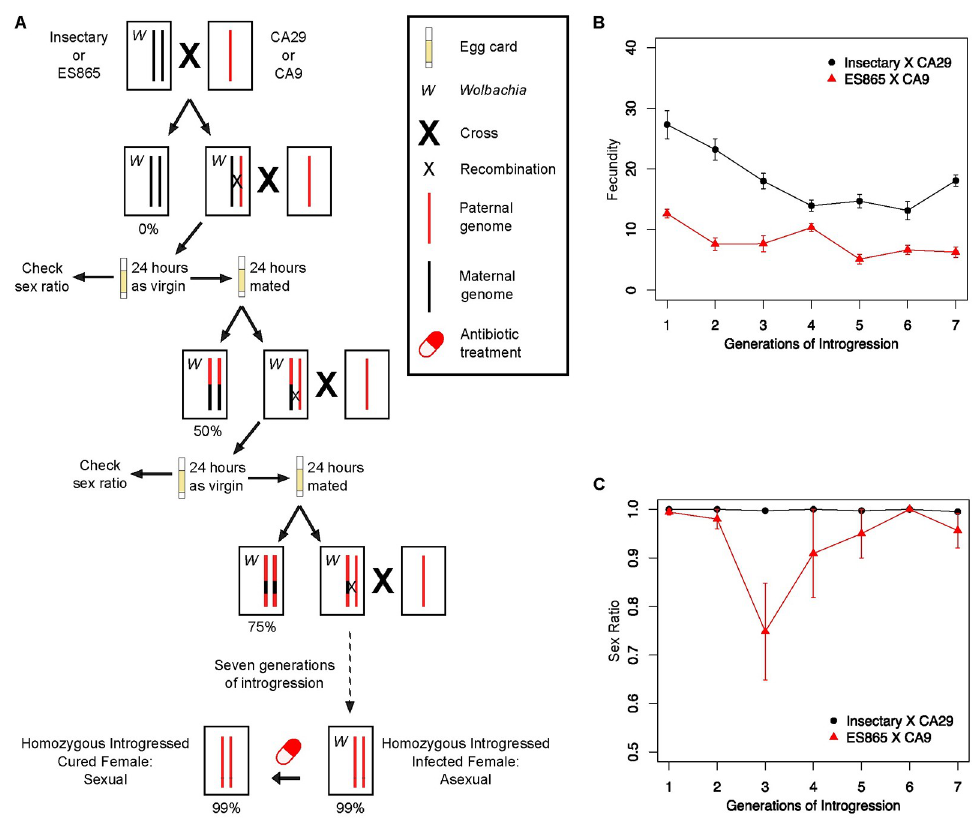
Fig 1. Crossing scheme for creating homozygous introgressed isofemale lines and fitness at each introgression generation. A) After seven generations of introgression, between 95–99% of the Wolbachia -dependent asexual nuclear background was replaced by the sexually reproducing nuclear background. At each generation of the introgression, we used virgin wasps to assay for sex ratio (a proxy for successful Wolbachia -mediated parthenogenesis) and fecundity prior to mating with a sexual male. All offspring were screened for zygosity, allowing for the identification of females produced via fertilization rather than Wolbachia -mediated parthenogenesis. This scheme was performed 3 independent times to generate 3 isofemale lines. B) Wasp fitness and C) efficiency of Wolbachia -mediated parthenogenesis at each generation of introgression. Sex ratio is denoted as the proportion of female